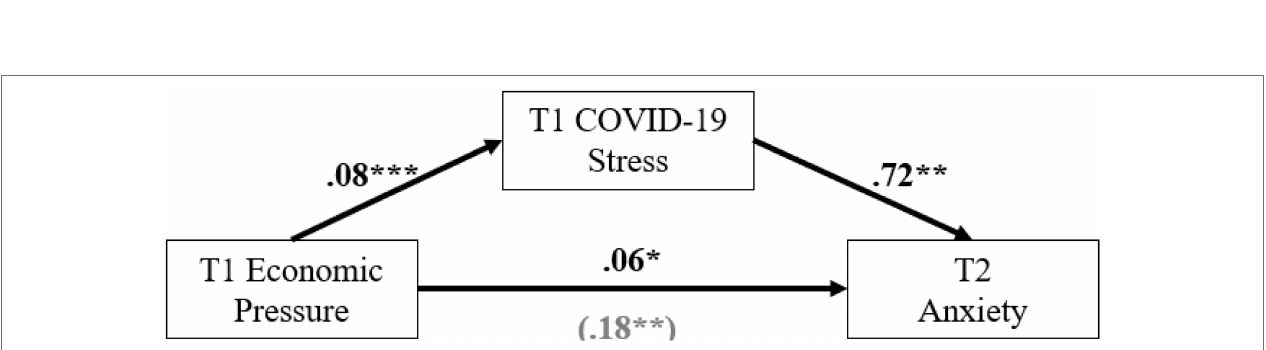
FIGURE 2 | COVID-19 stress as a mediator between economic pressure and later anxiety. * p < 0.05; ** p < 0.01; *** p <